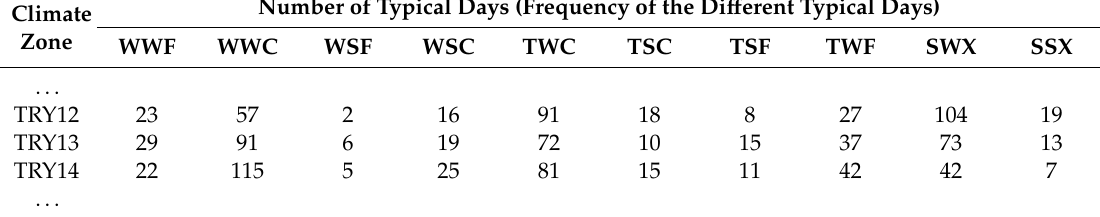
Table 3. Test reference years according to VDI 4655